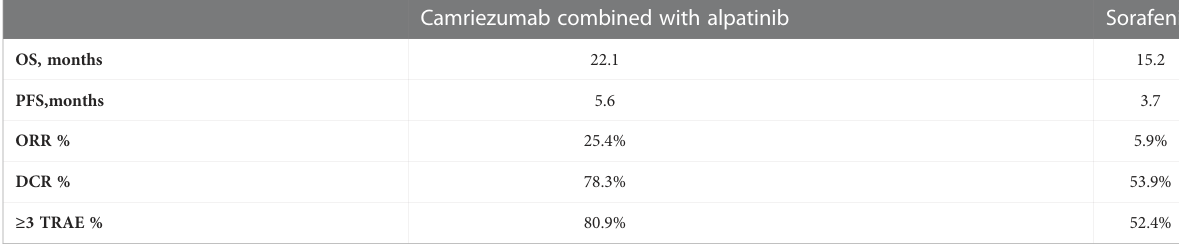
TABLE 3 Camrelizumab combined with apatinibhad vs